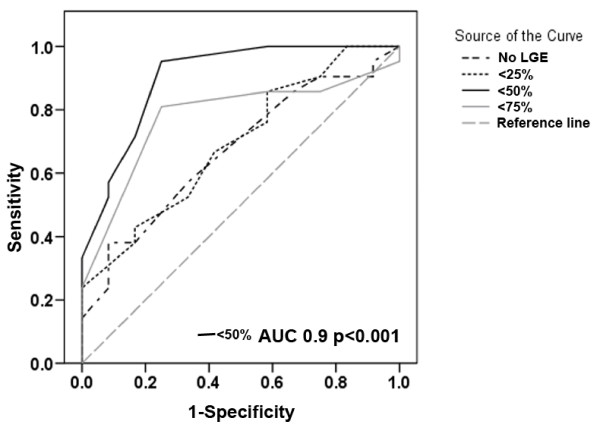
ROC analysis for the threshold of viable segments that predict global functional recovery. Legend shows various transmural extent of LGE. Optimal diagnostic performance was achieved with ≥10 viable+normal segments (segments affected by <50% LGE).